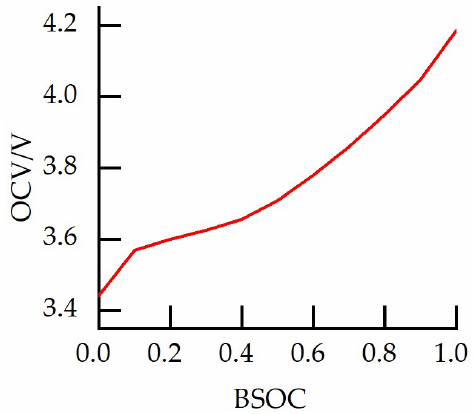
Figure 3. Relationship between OCV and BSOC.